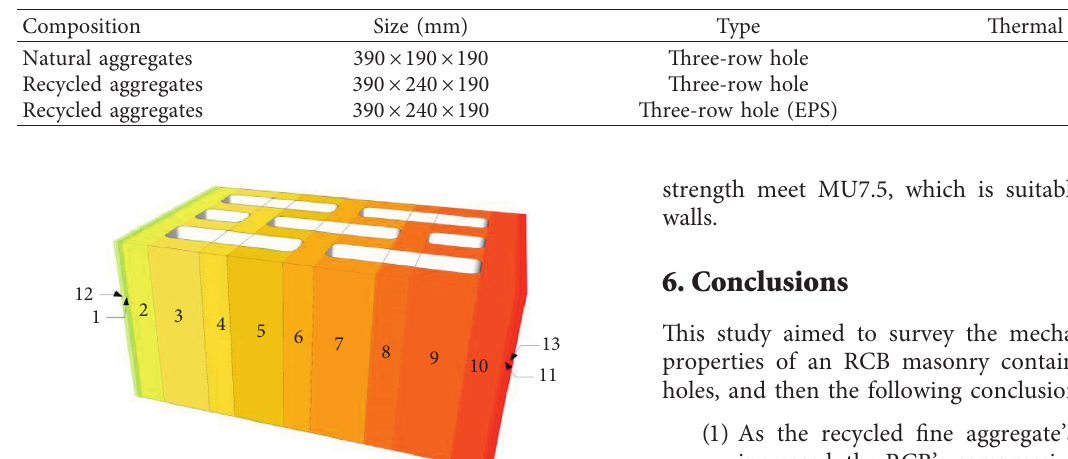
Table 9: Thermal parameters of block masonries.